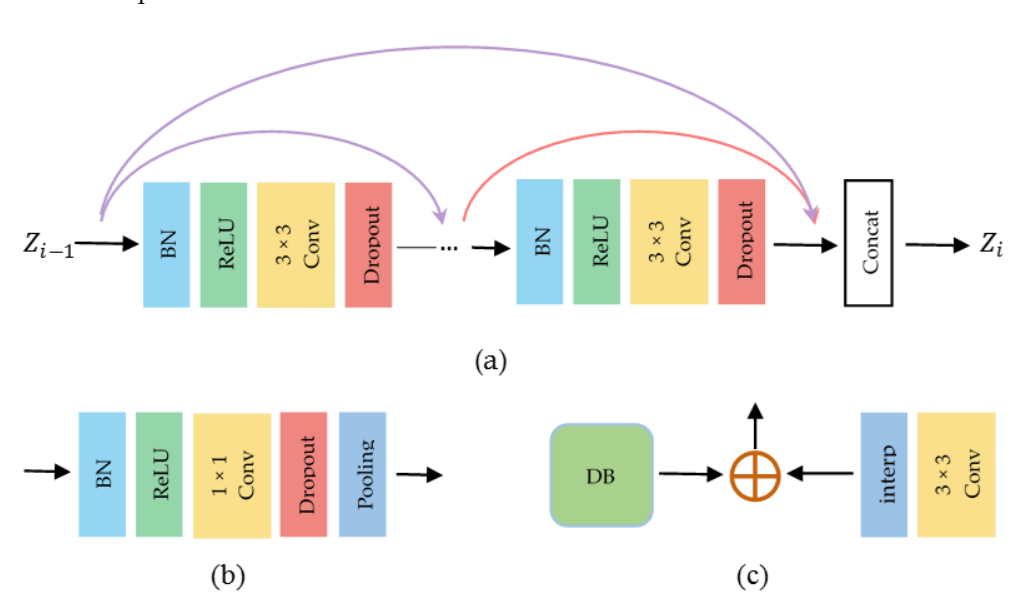
Figure 4. Basic layers of dense block, Transition Down, and Transition Up. ( a ) The dense block layer consists of BN, followed by ReLU and dropout; ( b ) Transition Down consists of BN followed by ReLU, dropout and a max-pooling of size 2 × 2; ( c ) Transition Up consists of a convolution, using nearest-neighbor interpolation to compensate for the loss of pooling process spatial information.